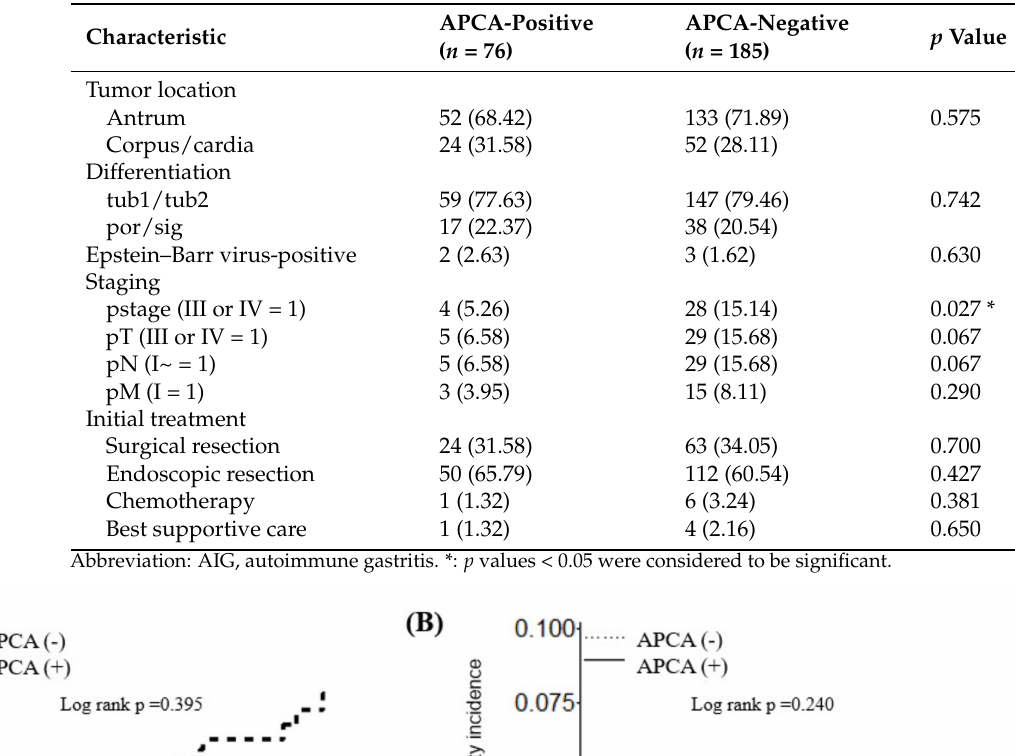
Table 2. Gastric cancer characteristics.